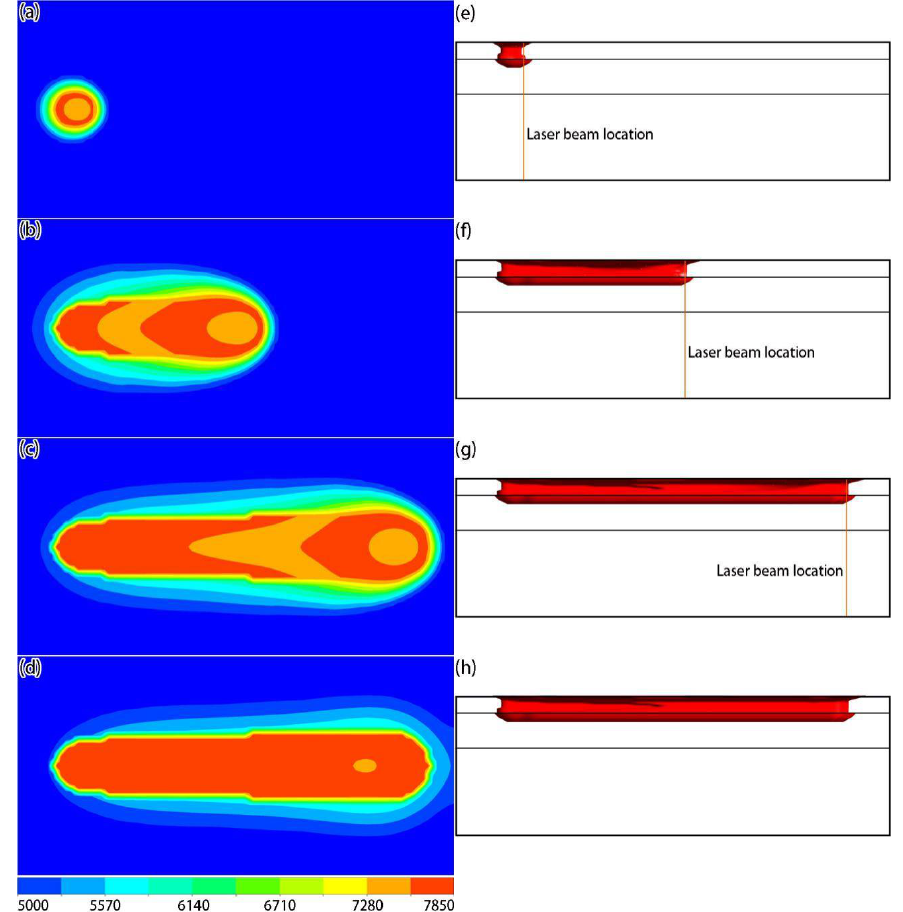
Figure 9. Simulation results of density distributions on the surface ( a – d ) and side-view solidified track shapes ( e – h ) at different times: ( a , e ) 6 × 10 −5 s; ( b , f ) 4.5 × 10 −4 s; ( c , g ) 8.4 × 10 −4 s; ( d , h ) 1.5 × 10 −3 s (unit: kg/m 3 ).